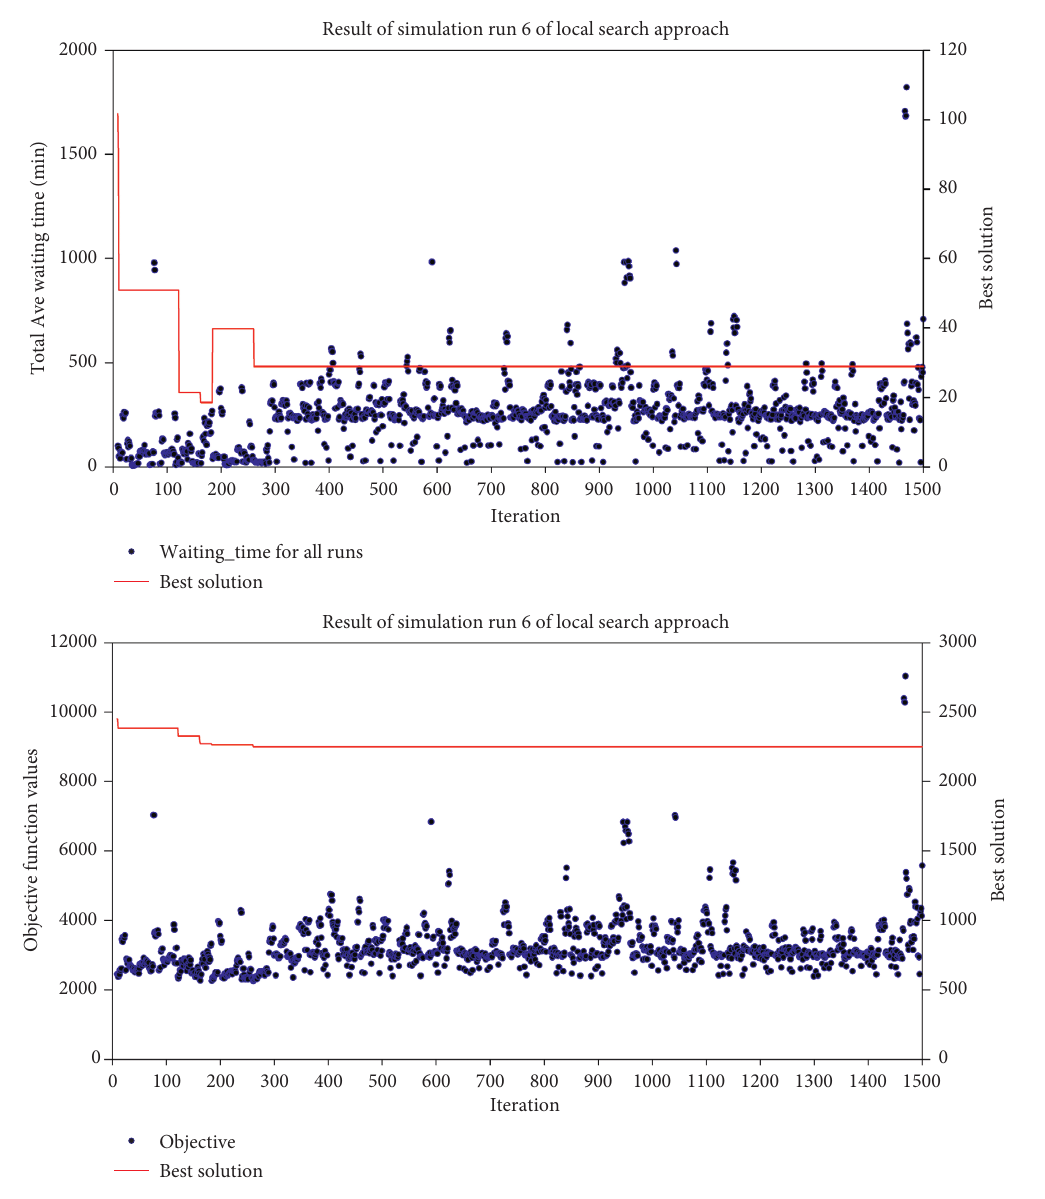
Figure 4: Optimisation results using the method of creating new solution using local